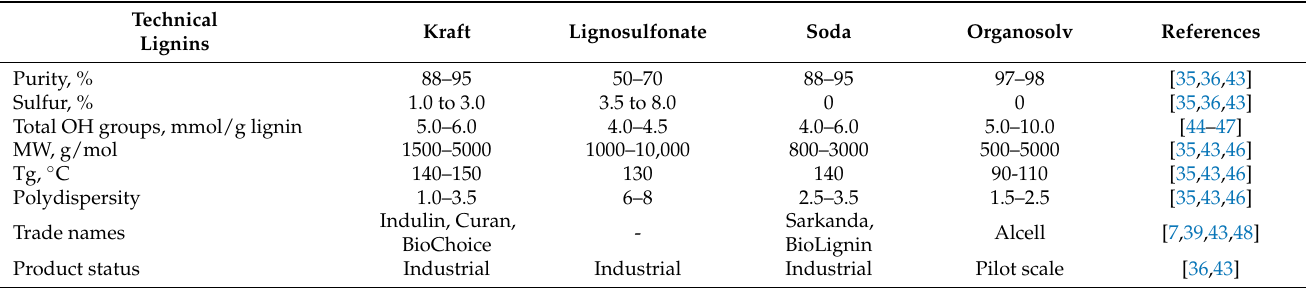
Table 2. Characteristics of technical